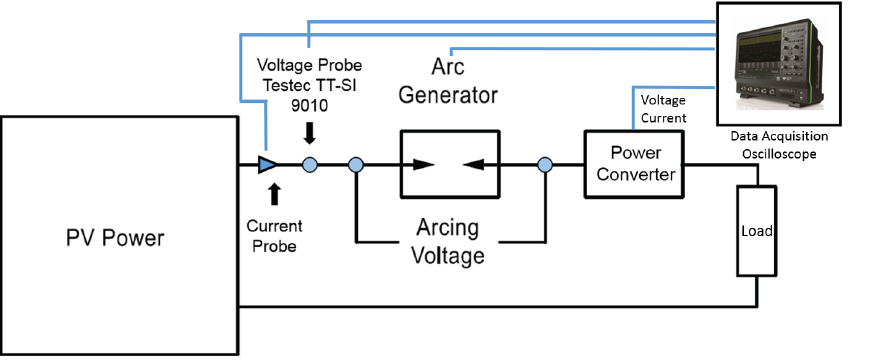
Figure 4. AF load study schematic diagram.